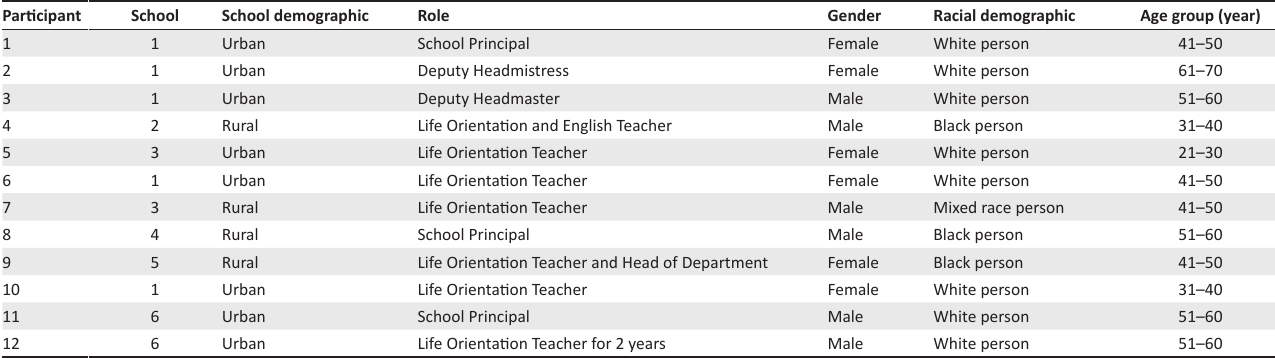
TABLE 1: Demographics of the study participants.